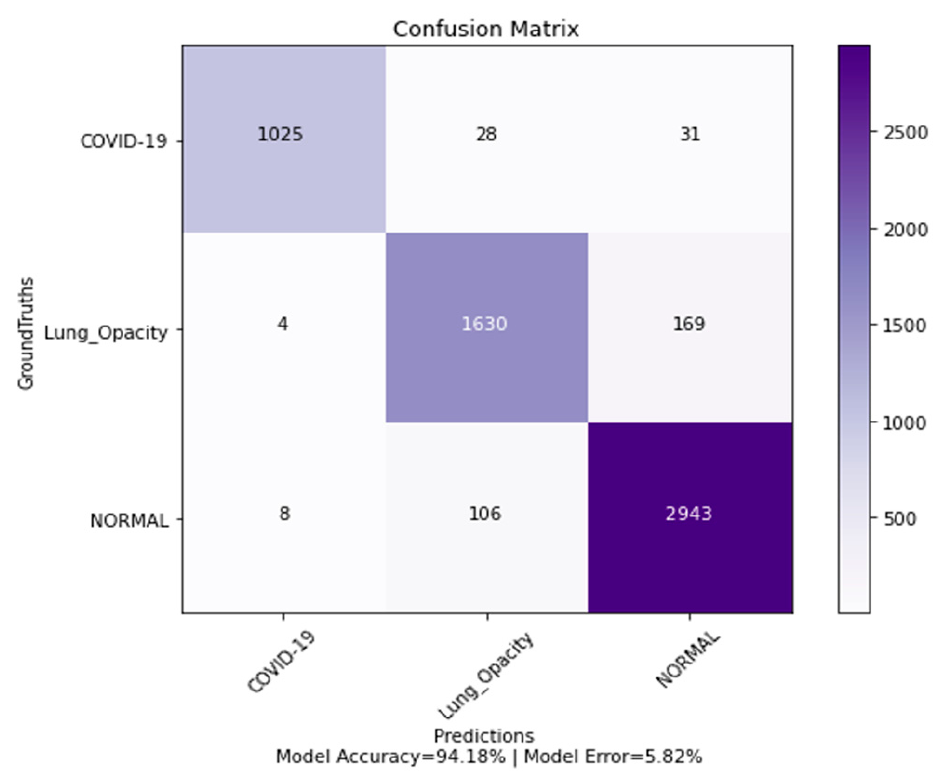
Figure 12. Confusion matrix for MobileNetV2 model.